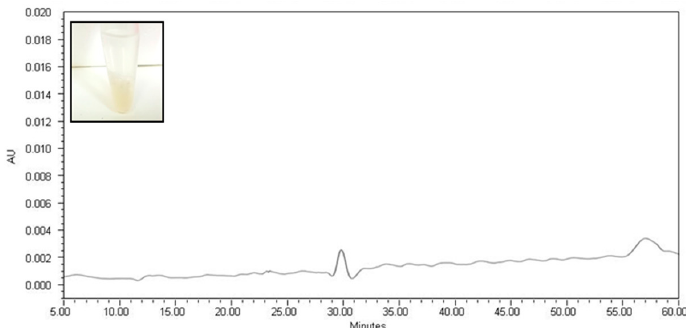
Figure 2. ( A ) BCX uptake by C. elegans . HPLC-PAD (High Performance Liquid Chromatography- Photodiode Array Detector) chromatograms of BCX ( β -Cryptoxanthin) standard; ( B ) pellet extract from worms previously fed with BCX at 1 μ g/mL; and ( C ) from worms grown under control condition (NGM (Nematode growth medium) without supplementation). Insert plots in ( A , B ) show the absorbance spectrum of the carotenoid peak identified in the chromatograms. Insert images in ( B , C ) show the corresponding worm pellets before disruption showing the differences in coloration. AU, arbitrary absorbance units.